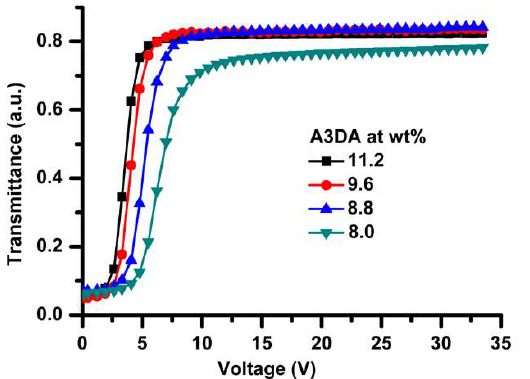
Figure 3. Voltage‐transmittance (V‐T) curves for PDLCs prepared with A3DA at different Figure 3. Voltage-transmittance (V-T) curves for PDLCs prepared with A3DA at di ff erent concentrations concentrations at 303 K, λ = 633 nm. at 303 K, λ = 633